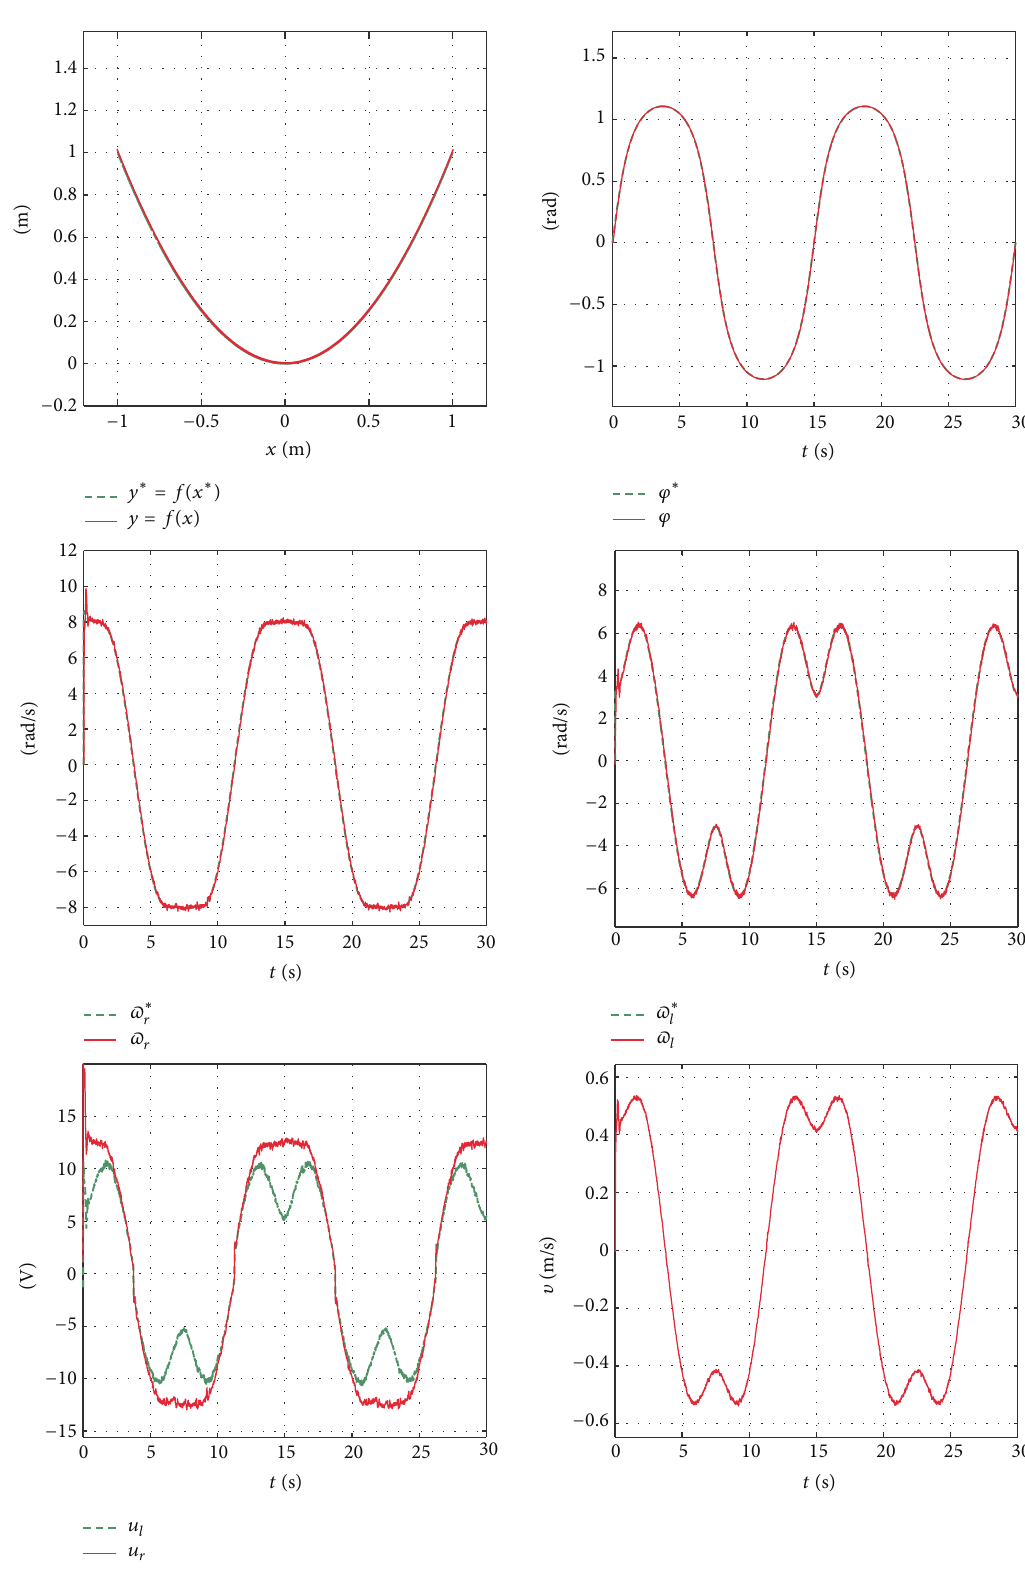
Figure 17: Real-time experimental